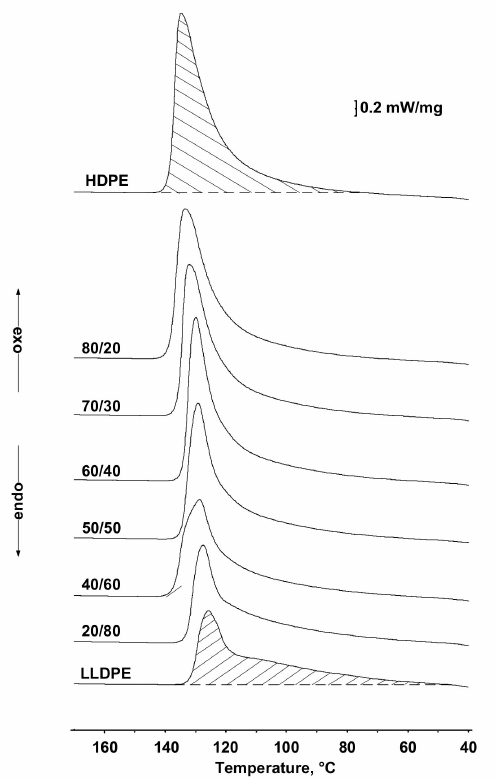
Figure 10. The effect of LLDPE on the DSC curves of HDPE/LLDPE blends. In the case of testing deformation resistance properties at subzero temperatures for ◦ C the initial HDPE, the E b − 45 value was 85%, being equal to 180% (i.e., twice as high) for the blend with HDPE/LLDPE = 70/30 (Figure 11). The rise in relative elongation at break at − 45 ◦ C for the blends seems to be caused by the increasing content of comonomer units (i.e., increasing degree of branching) (Table 6). The content of the amorphous fraction increases, while crystallinity and ductility decrease [34], thus exhibiting a favorable effect on elasticity at low temperatures.